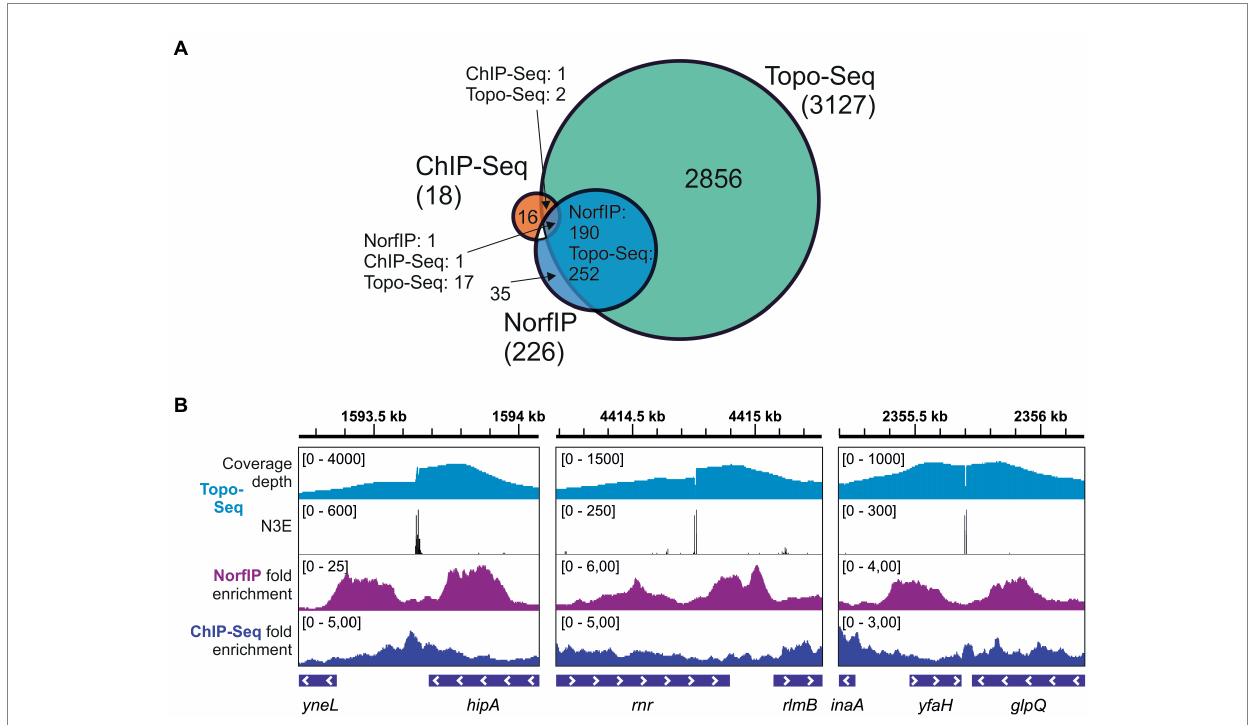
FIGURE 4 Sensitivity and precision of Topo-Seq. (A) A Venn diagram representing colocalization of Topo IV binding sites identified with ChIP-Seq and TCSs identified with NorfIP and Topo-Seq. Numbers of binding/cleavage sites are given for each subset, the total number of sites is shown in parentheses. (B) Representative genomic regions with binding/cleavage sites detected with ChIP-Seq, NorfIP, and Topo-Seq. ChIP-Seq and NorfIP data are taken from El Sayyed et al. (2016) and mapped to the E. coli reference genome